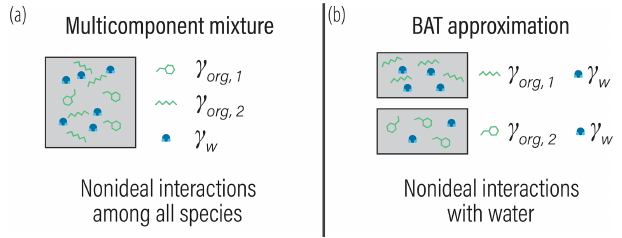
Figure 1. (a) Schematic of a realistic model for mixture compo- nent activity coefficients, accounting for nonideal interactions be- tween all species. (b) The BAT approximation separates the organic species and treats each organic species as a binary mixture with water. The water mole fraction in each binary mixture is then equi- librated with the gas-phase water activity (i.e., RH). The water and organic masses in the equilibrated binary mixtures are then added together to represent the total liquid